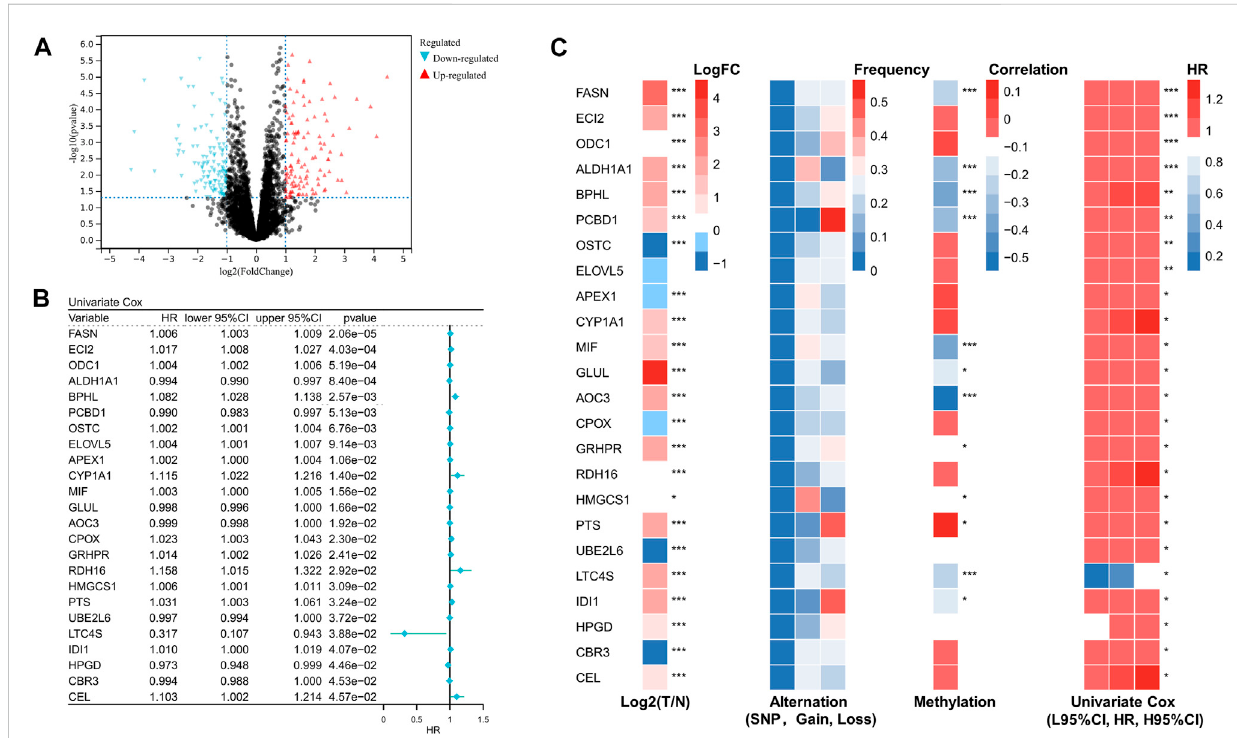
FIGURE 1 Identi fi cation of prognostic fatty acid metabolism related-gene in soft tissue sarcoma. (A) Volcano map of the differentially expressed genes associated with prognosis in the STS cohort. (B) Univariate analysis of differentially expressed fatty acid metabolism-related genes in STS. (C) The expression, alteration, and methylation level of differentially expressed fatty acid metabolism-related genes in